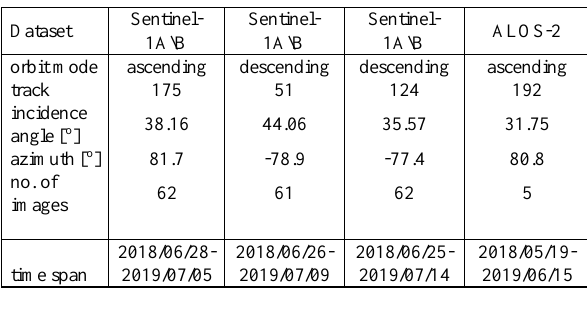
Table 1. Specification of the SAR data